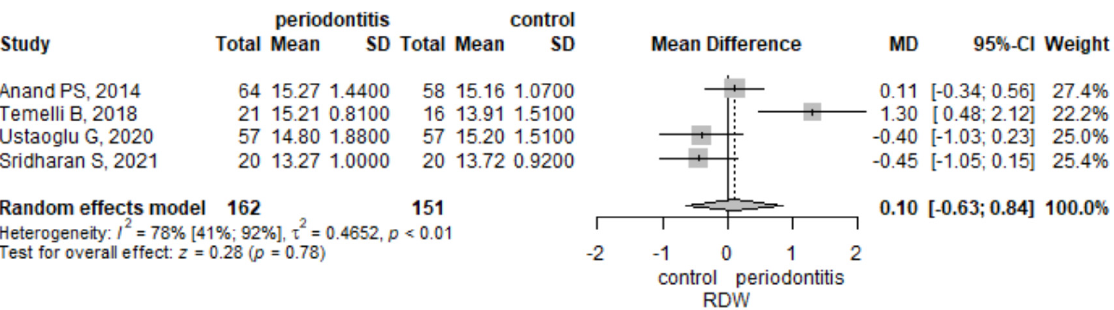
Figure 5. Red cell distribution width-mean difference between periodontitis and control subjects.